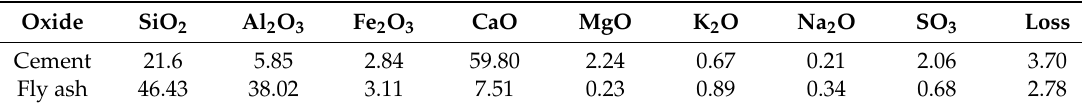
Table 1. Chemical analysis of cement and fly ash.